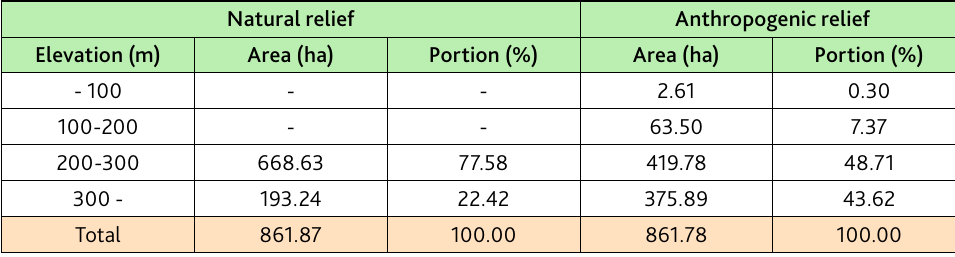
Table 1. Categories and spatial dimensions of elevation Natural relief Anthropogenic